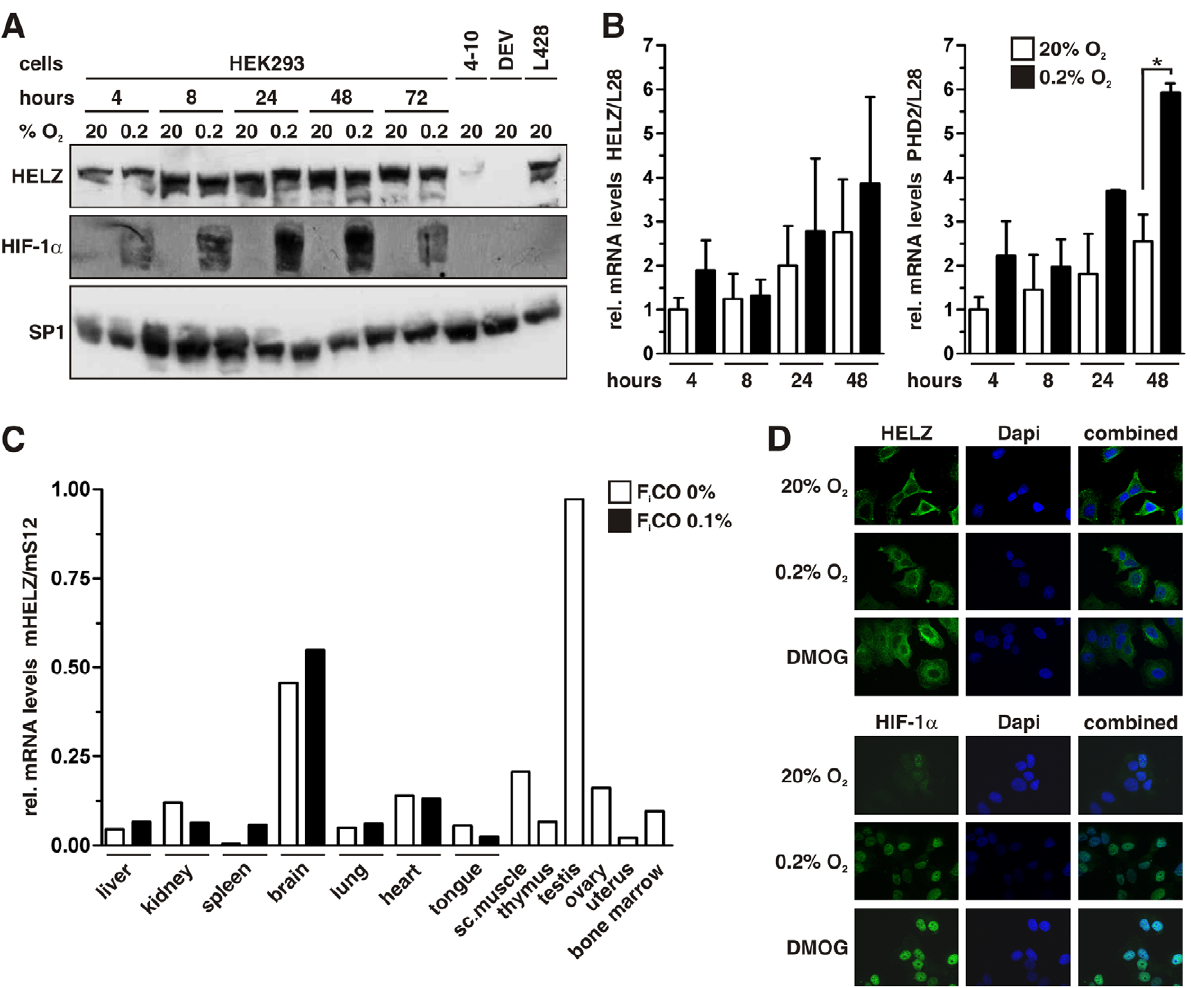
Figure 2. Oxygen-independent regulation of HELZ. ( A ) Immunoblot analysis of HEK293 cells cultured under normoxic or hypoxic conditions for the indicated time periods. The stable HELZ shRNA clone 4–10 and the Hodgkin’s lymphoma-derived cell line DEV containing a homozygous deletion on chromosome 17 served as controls for reduced and absent HELZ protein levels, respectively. The Hodgkin’s lymphoma derived cell line L428 served as positive control. ( B ) Transcript levels of HELZ were analyzed in HEK293 cells by RT-qPCR. Cells were exposed to hypoxia (0.2% O 2 ) for up to 48 hours and PHD2 served as hypoxia-inducible control. ( C ) Total RNA was extracted from tissue samples of various organs from mice exposed to inspiratory air (0% F i CO) or 0.1% carbon monoxide (0.1% F i CO) for 4 hours and HELZ transcript levels were quantified by RT-qPCR and normalized to ribosomal protein S12 mRNA levels. ( D ) MCF-7 cells were cultured under 20% O 2 or 0.2% O 2 for 18 hours, fixed, and HELZ as well as HIF-1 a protein visualized by indirect